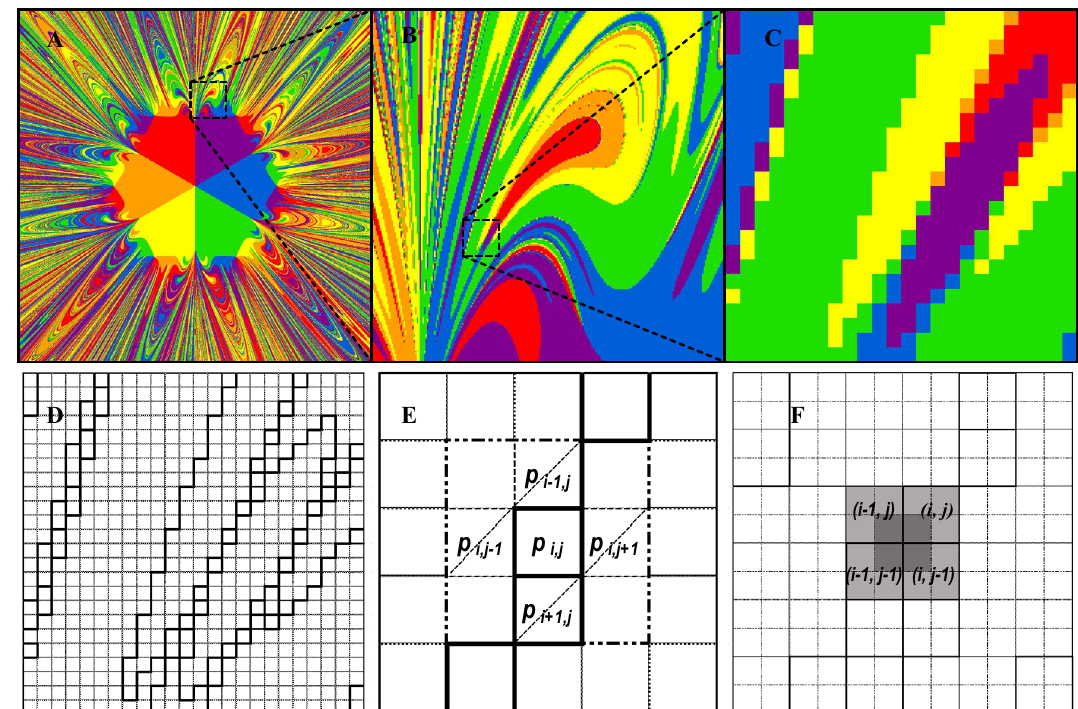
Figure 2. Methods of counting fractal dimensions for randomly selected magnifications of a fragment in hexagonal space. Legend: ( A–C ) Magnification of randomly selected fragment of fractal; ( D ) Boundary of attraction basins in selected fragment; ( E ) Ruler dimension determined by the 4 neighboring pixels of each boundary pixel; ( F ) Box dimension depends on 4 adjacent pixels with one of them being a boundary